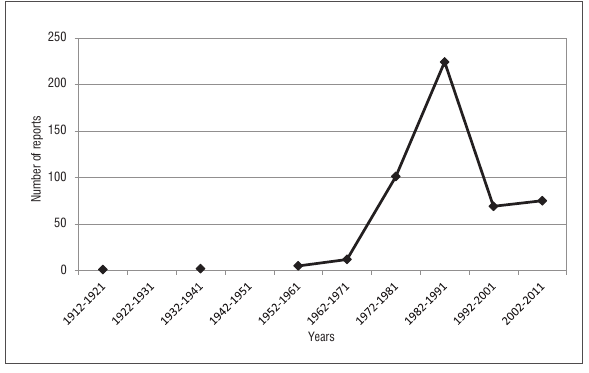
Figure 7: Number of estuarine reports produced per decade between 1912 and